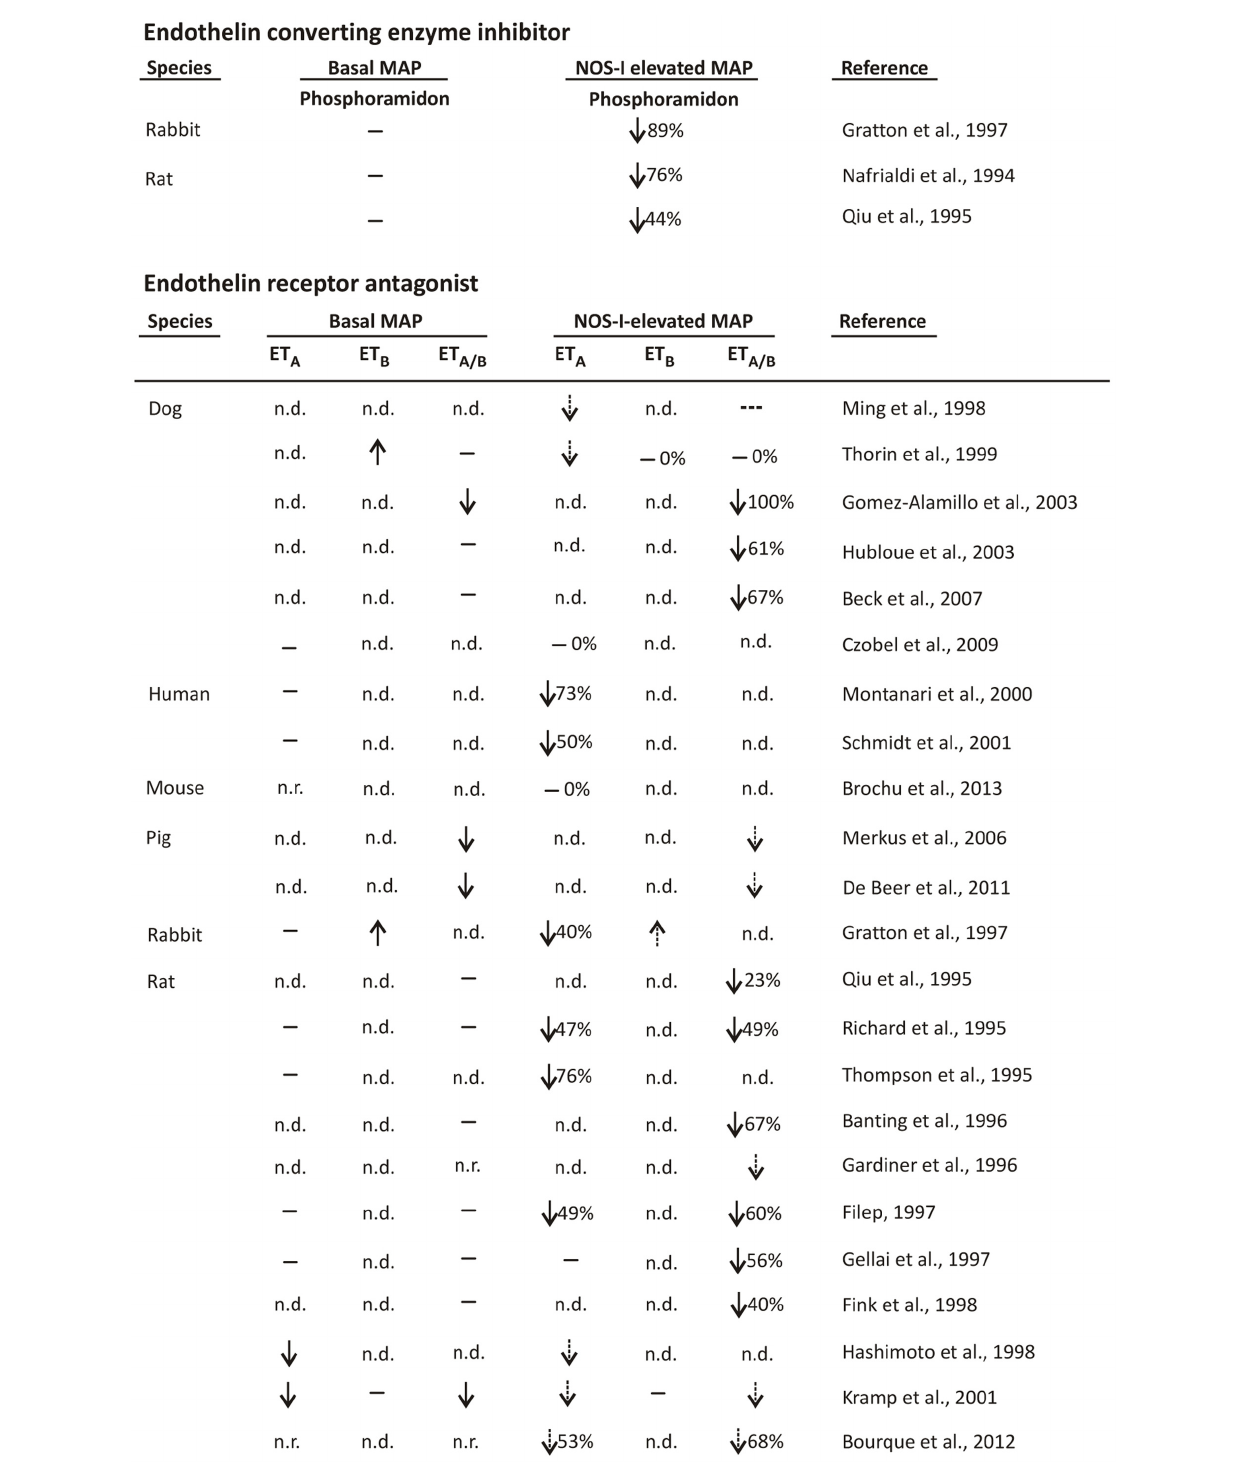
and broken dash represent the directional change and lack of change, respectively, in NOS inhibitor-elevated pressure by ET receptor antagonist as compared to NOS inhibitor-elevated basal pressure in the absence of ET receptor antagonist. Percent inhibitions shown represent reported values or, if not reported, were estimates. Fink etal. (1998) utilized stroke-prone spontaneously hypertensive rat.